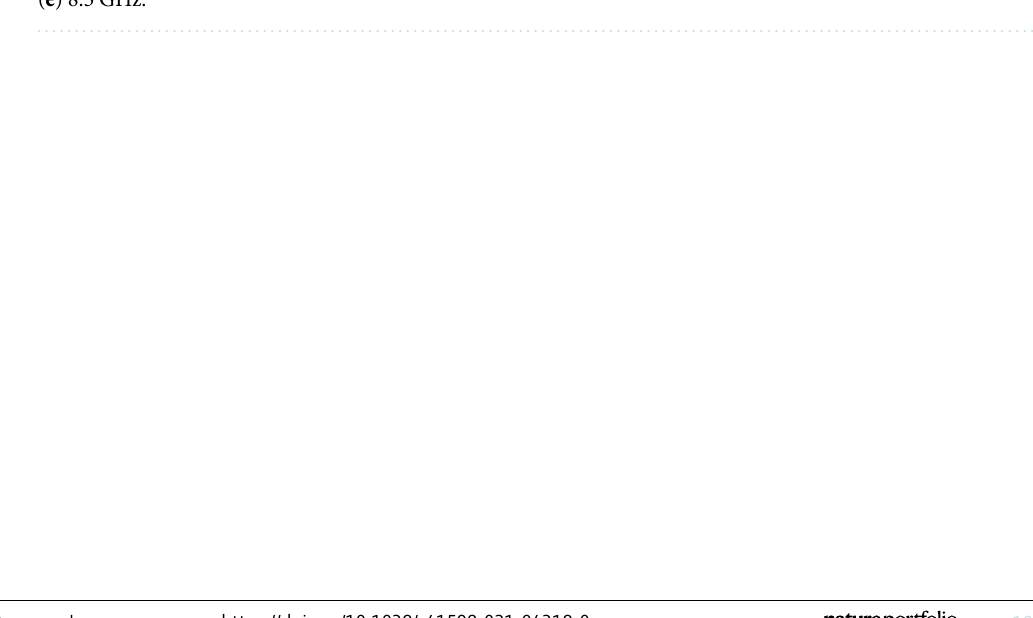
Figure 20. On-car performance of the proposed antenna: ( a ) 1.8 GHz, ( b ) 2.4 GHz, ( c ) 3.1 GHz, ( d ) 6.8 GHz, ( e ) 8.5